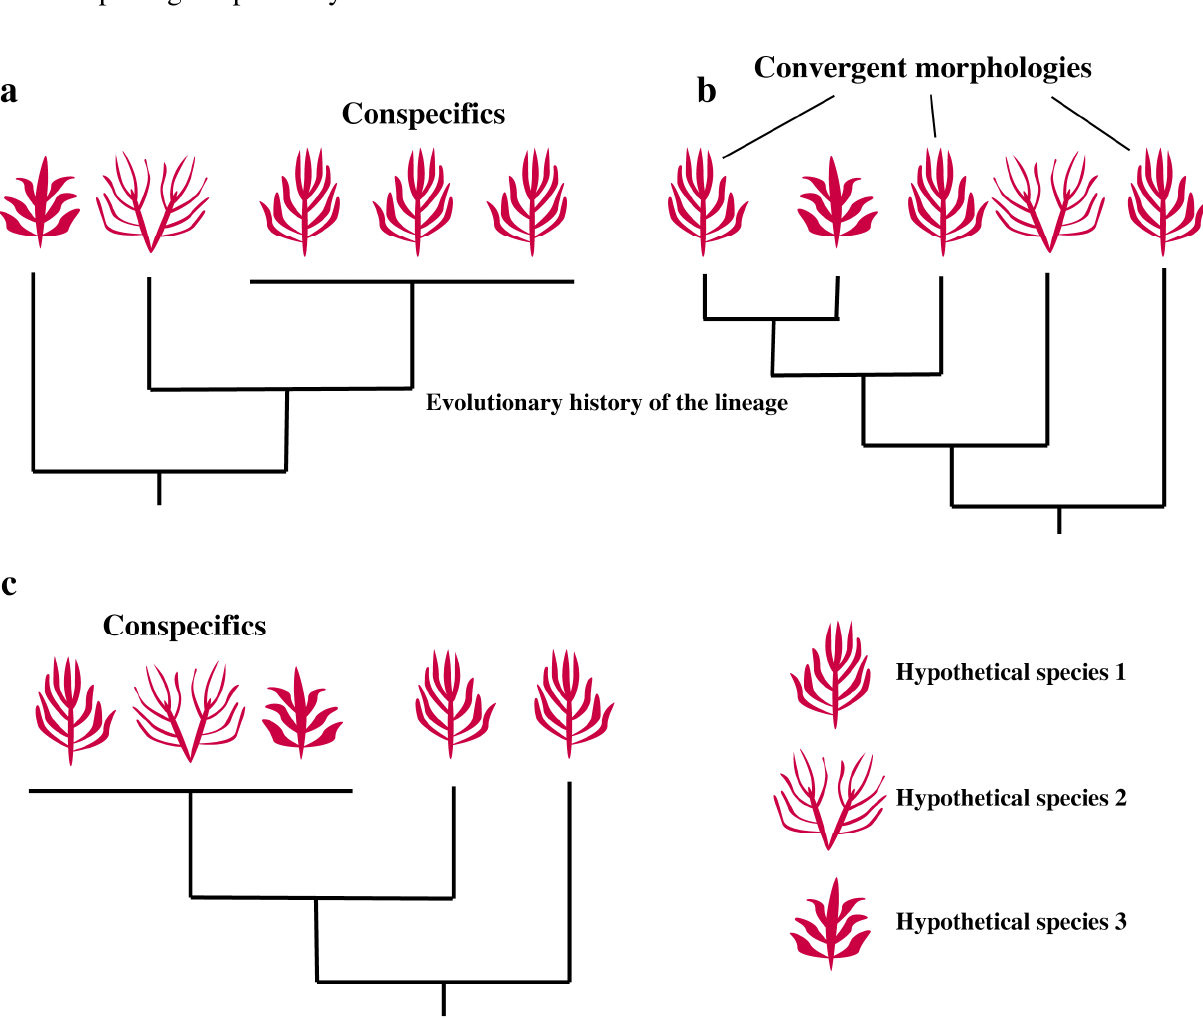
Figure 1. Possible scenarios resulting from the application of molecular-assisted alpha taxonomy. Species of algae, classified based on morphology, are